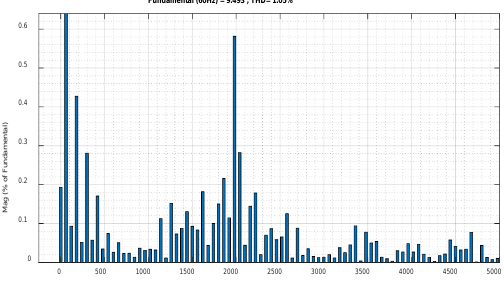
Figure 16. THD of the output current.